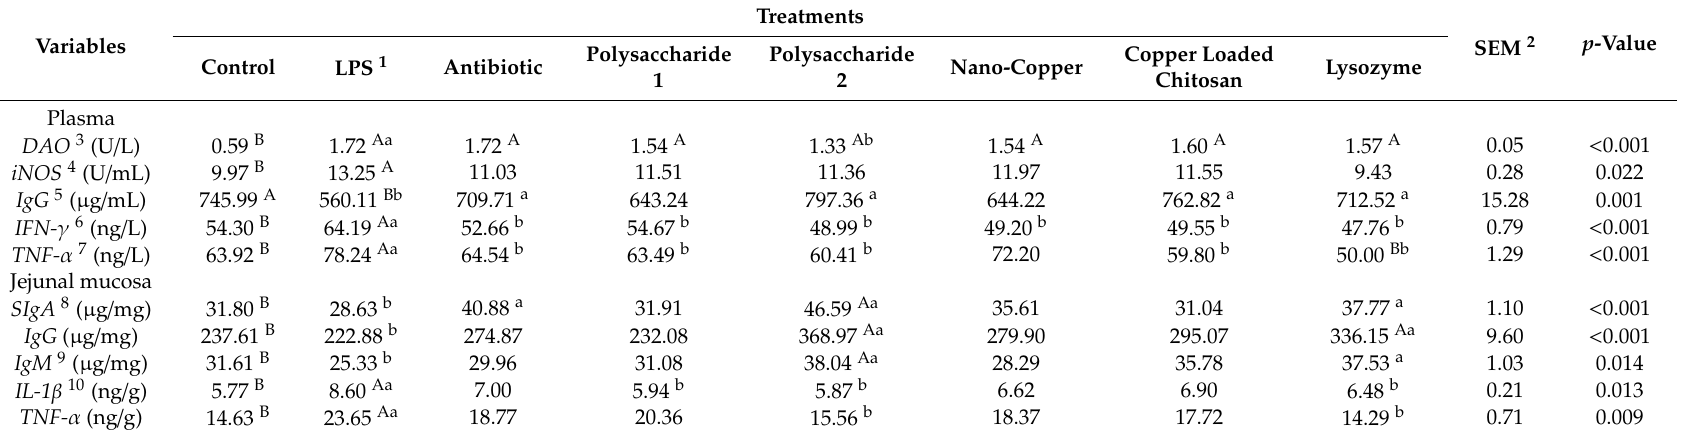
Table 4. E ff ects of mushroom polysaccharide, nano-copper, copper loaded chitosan, and lysozyme on plasma and jejunal mucosa biochemical variables of yellow-feathered chickens challenged with lipopolysaccharides